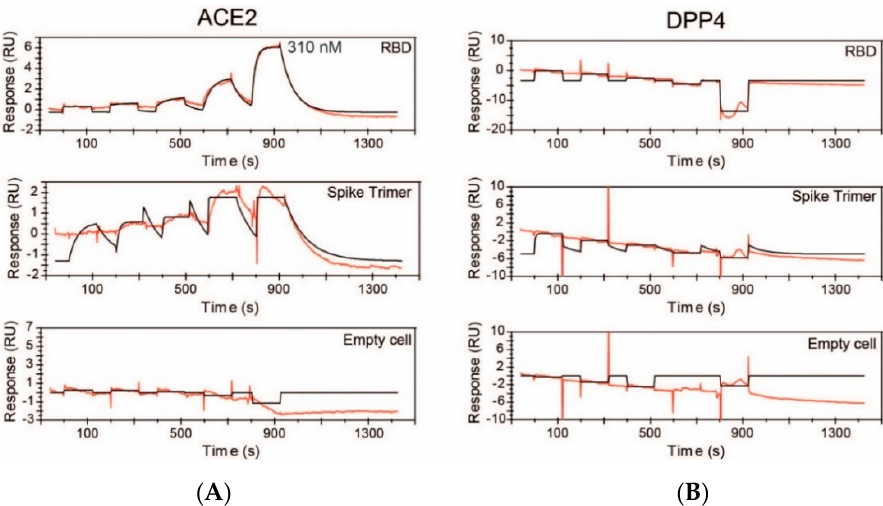
Figure 4. Surface plasmon resonance assays. Purified soluble human ACE2 ( A ) and DPP4 ( B ) were exposed to CM5 chips that had been coated with SARS-CoV-2 RBD or spike protein, or were not coated. Experimental data are shown in red. Calculated data fit using a 1:1 binding model are shown in black. Ligands were injected at increasing concentrations of ( A ) ACE2 at 0.50 nM, 2.5 nM, 12 nM, 62 nM and 310 nM and ( B ) DPP4 at 1.6 nM, 8.0 nM, 40 nM, 200 nM and 1000 nM.